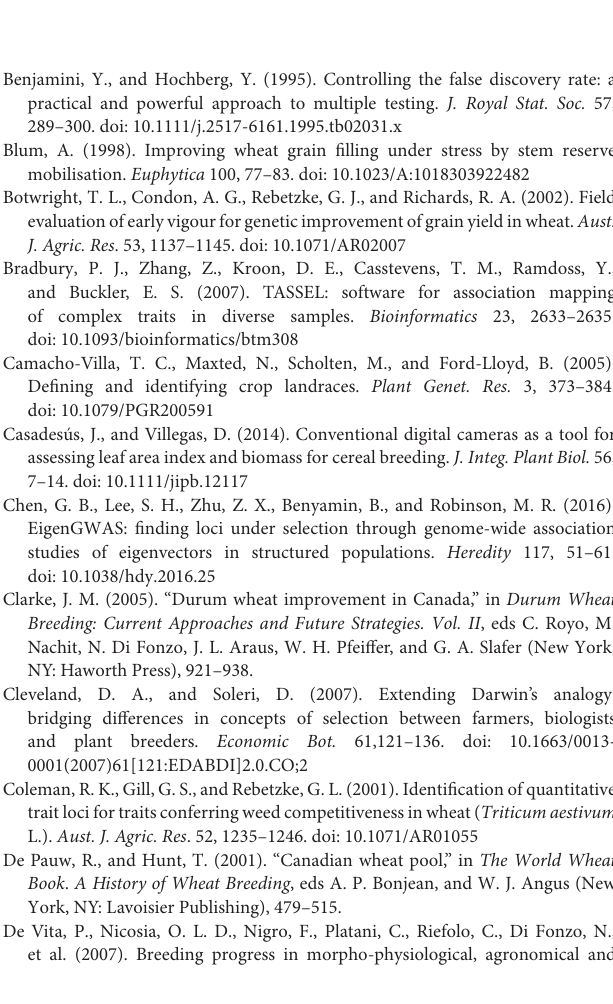
each crop season. The lowest figures indicate the water soil content at three depths (0–40, 10–40, and 25–40cm) for each year. Supplementary Figure 2 | Number of landraces (green) and modern cultivars (red) in each range of values for the agronomic traits analyzed. Supplementary Figure 3 | Correlations between the 21 phenotypic traits in landraces ( n = 172) and modern cultivars ( n = 200). Positive and negative correlation coefficients (r) are indicated in red and blue colors, respectively, with the color intensity associated to the values. P < 0.05 for 0.14 > r < 0.19; P < Supplementary Table 1 | Genotypes included in the study with their genetic structure coefficients ( q ). Supplementary Table 2 | Mean values across years of the studied traits for each genotype. Supplementary Table 3 | GWAS results. Supplementary Table 4 | QTL